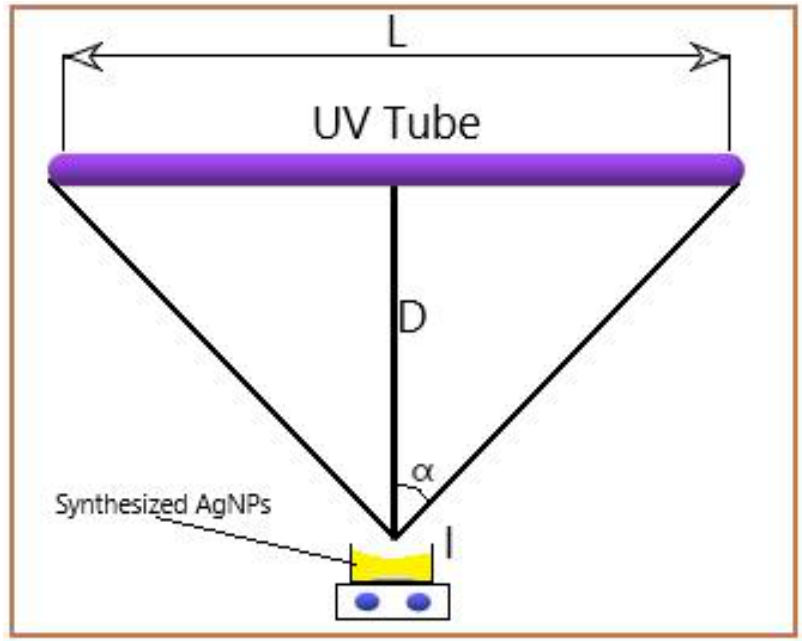
Figure 1. Schematic representation of the synthesis. Figure 13. Schematic representation of the